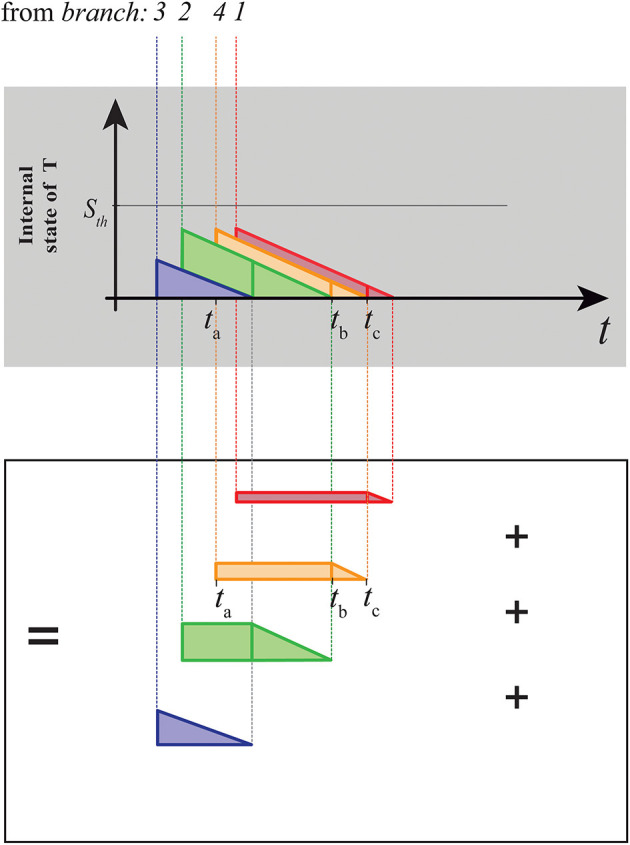
Decomposition of the area subtended by the internal state of the target neuron shown in Figure 4A in terms of trapezoids. Considering the arrival of a generic contribution to the target neuron (e.g., the orange one in A), its advent (at the time ta) will cause an immediate increase of the value of ST equals to the target weight associated to the afferent contribution. Its contribution on the ST can be considered an additive constant, until the decay due to the previous contribution is exhausted (interval [ta, tb], i.e., rectangle part). After this, its contribution will start to decrease linearly (with slope Ld) until the resting potential is reached (interval [tb, tc], i.e., triangle part).